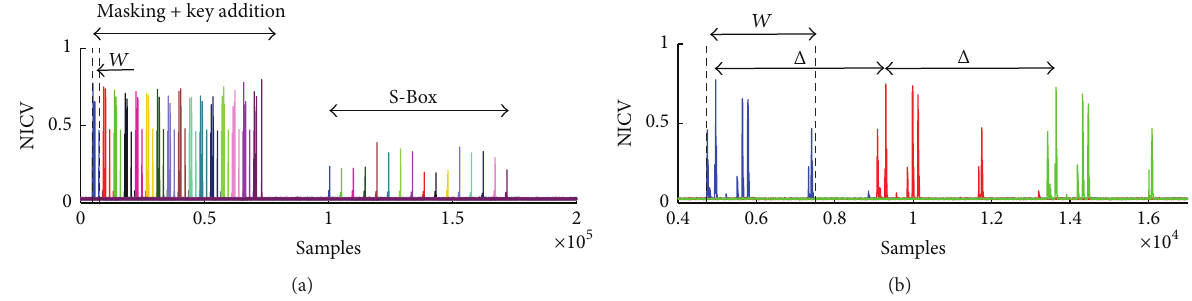
Figure 2: NICV for each plaintext byte over 10, 000 traces. (a) AES operations are identifiable. (b) NICV for the first 3 bytes of plaintext. Each byte exhibits similar characteristics, which implies the operation taking place a number times, but each time processing different